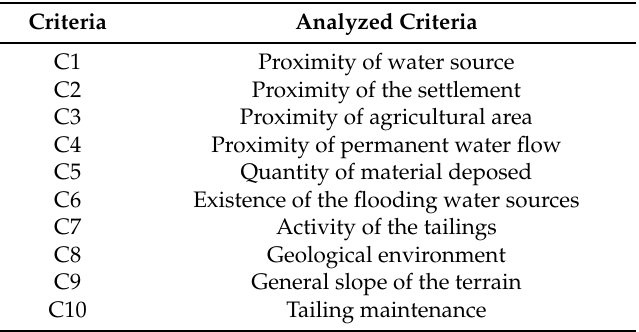
Table 4. Presentation of criteria of analyzed flotation ponds.